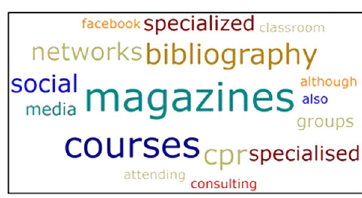
Fig. 1 Word cloud for the subcategory procedure. Source: fi gure